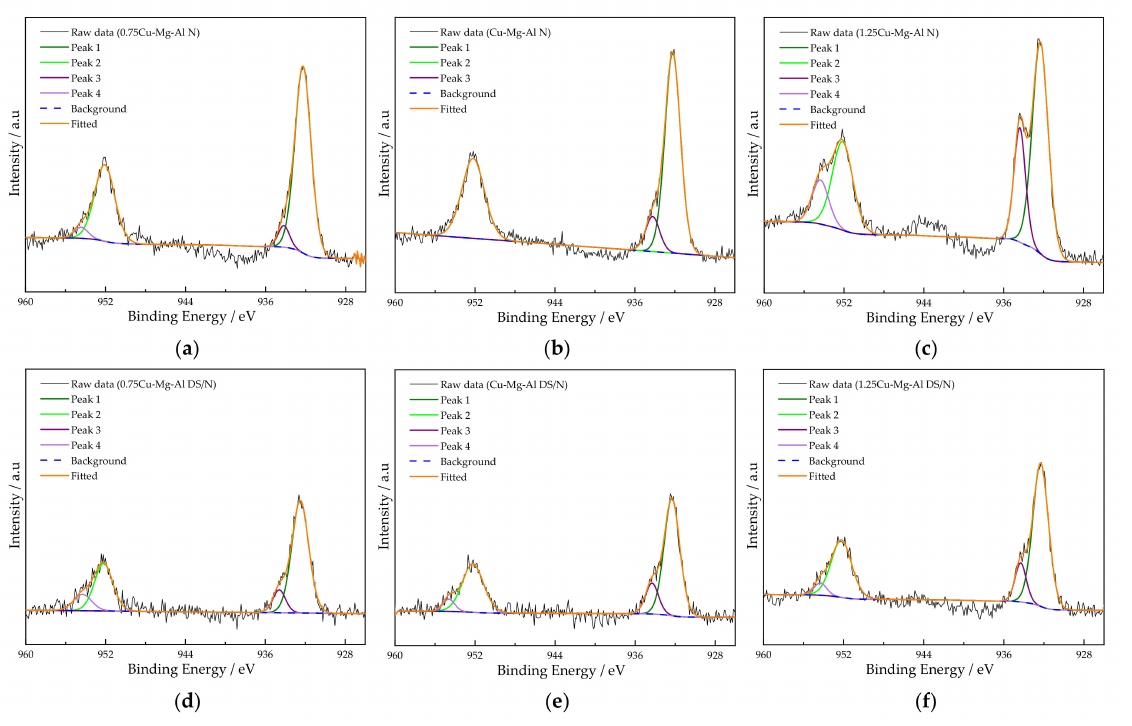
Figure 6. The high-resolution spectra of Cu 2p of xCu-Mg-Al DS/N and xCu-Mg-Al N: ( a ) 0.75Cu- Mg-Al N; ( b ) Cu-Mg-Al N; ( c ) 1.25Cu-Mg-Al N; ( d ) 0.75Cu-Mg-Al DS/N; ( e ) Cu-Mg-Al DS/N; ( f ) 1.25Cu-Mg-Al